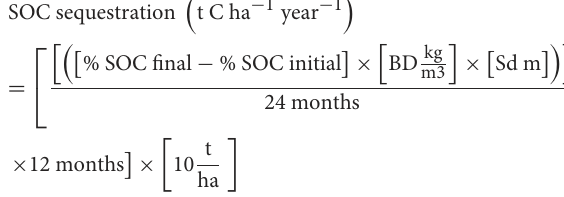
Wheat Mung bean Sesame